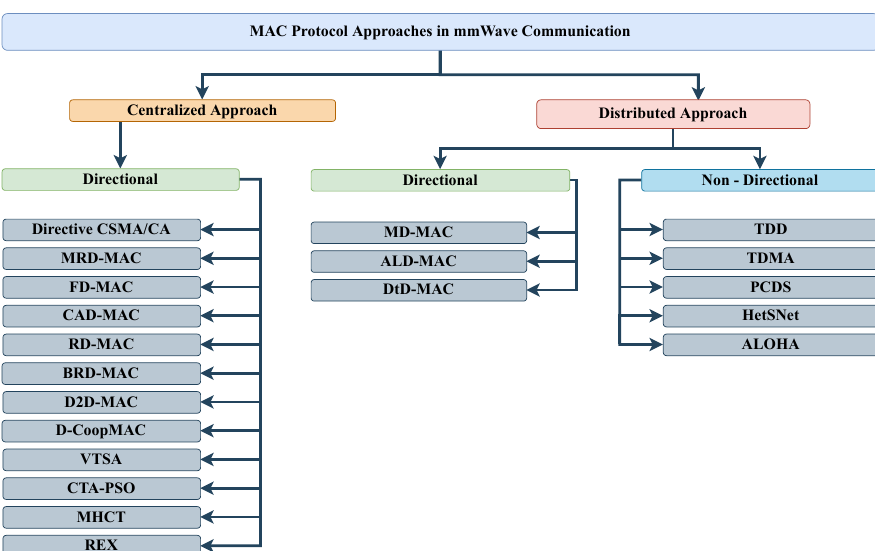
Figure 1. Structural classification of MAC